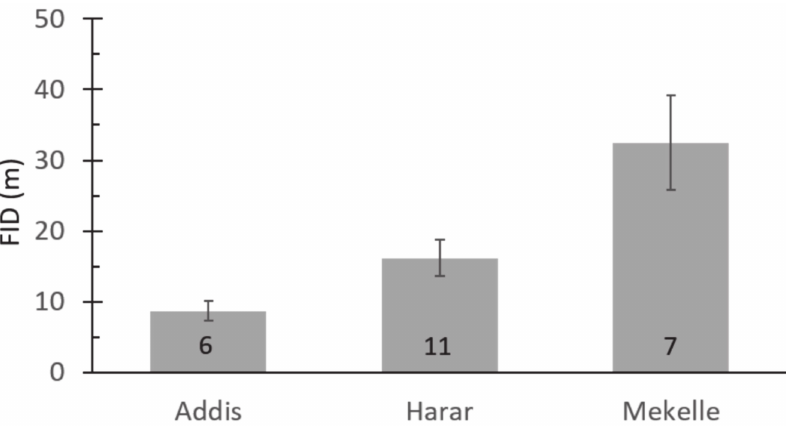
Figure 3. Average ( ± SE) flight initiation distances of spotted hyenas in three Ethiopian cities, with sample sizes shown inside the bars. FID: Flight Initiation